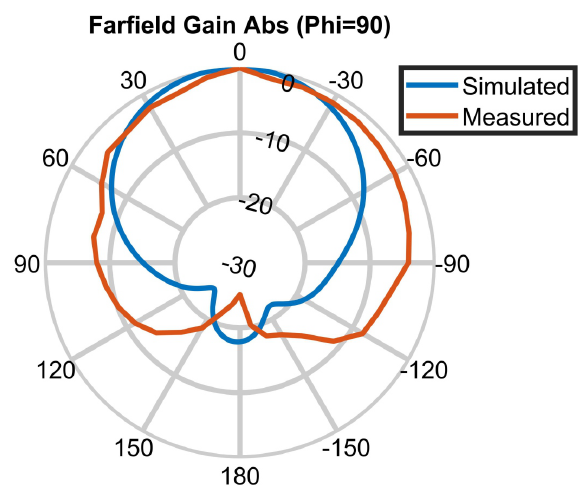
FIGURE 17. Simulated and measured normalized radiation patterns of the HGWMPA at 5.4 GHz (Phi=90 deg. plane).